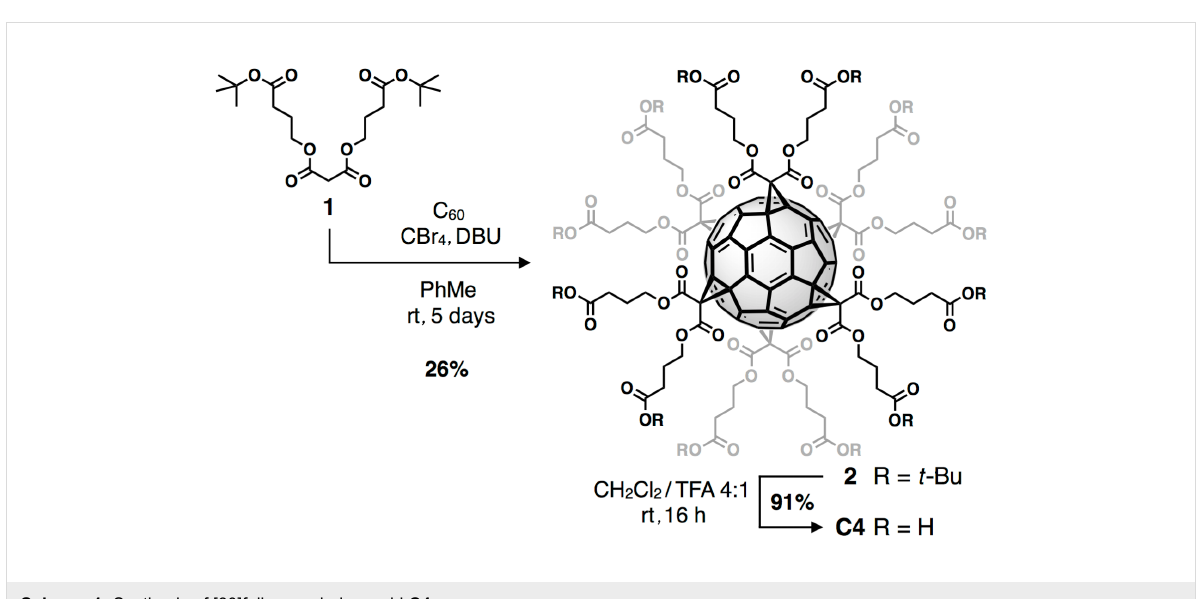
Scheme 1: Synthesis of [60]fullerene dodecaacid C4